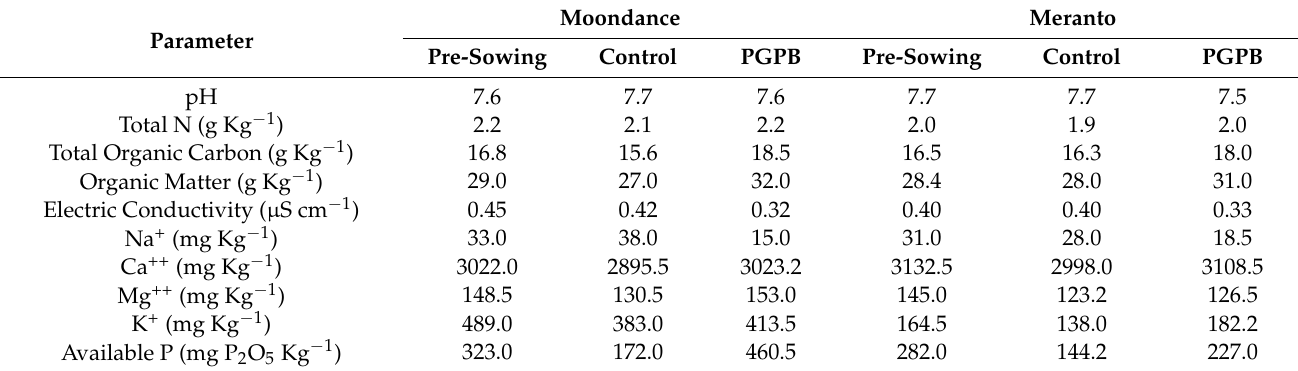
Table 1. Dry weight, total phenolic content, and antioxidant activity of bulbs of Meranto and Moondance cultivars.